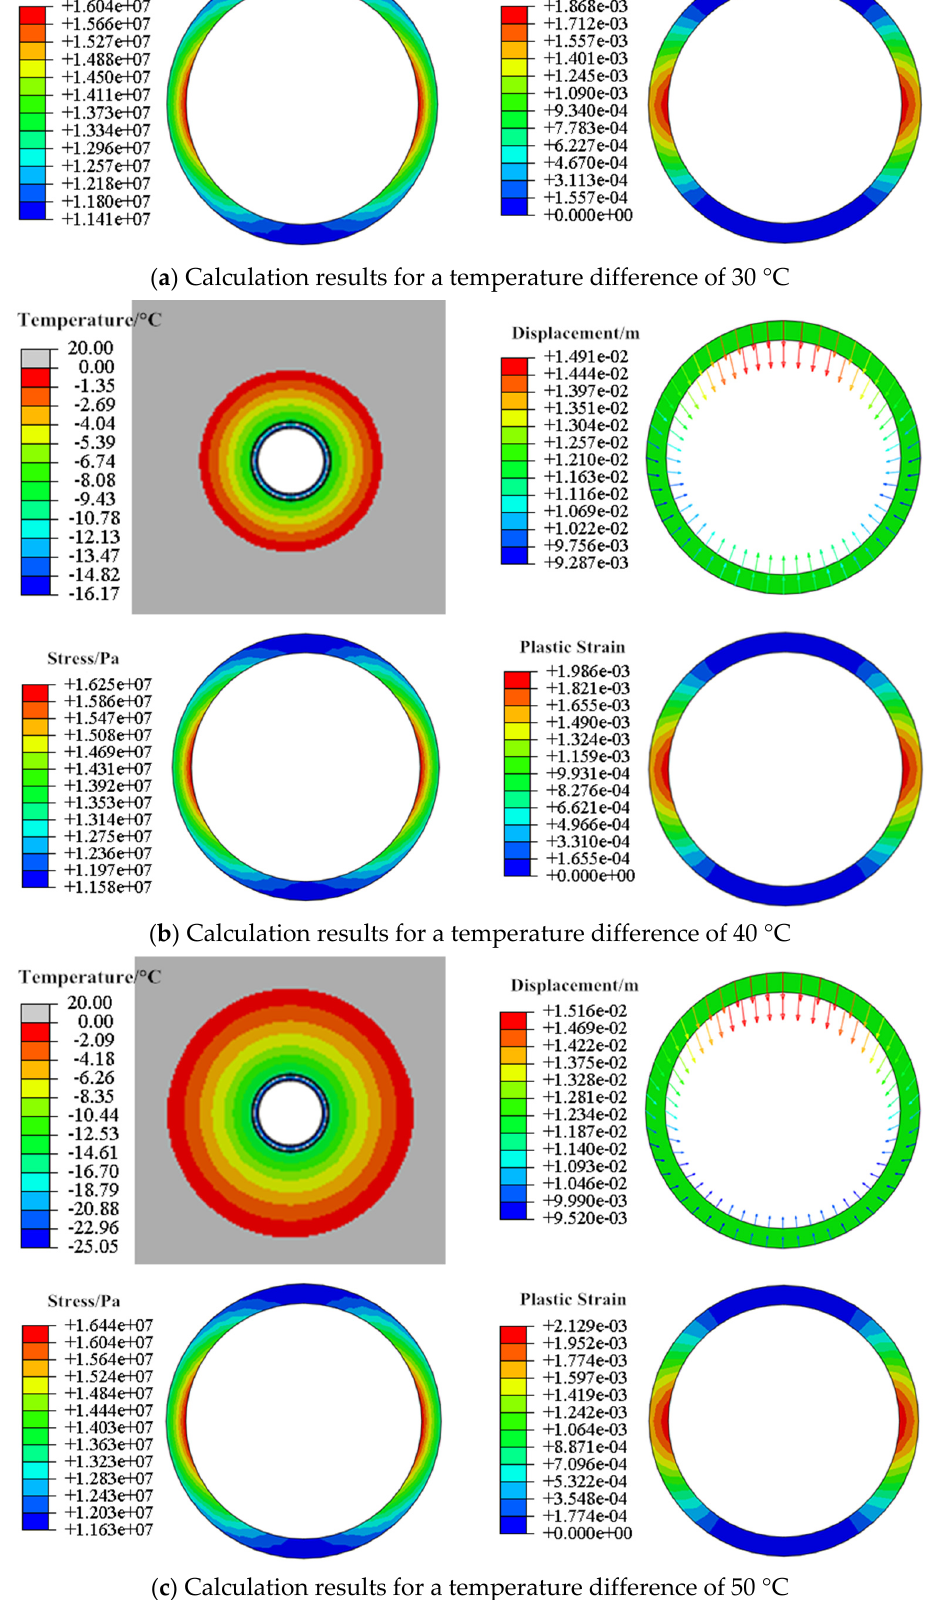
Figure 8. Influence of different temperature differences on bearing characteristics.